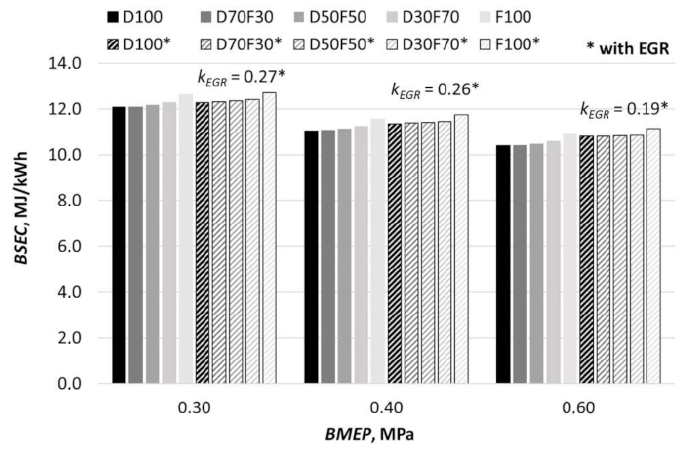
Figure 11. Dependence of brake specific energy consumption on fuel composition and the engine load.